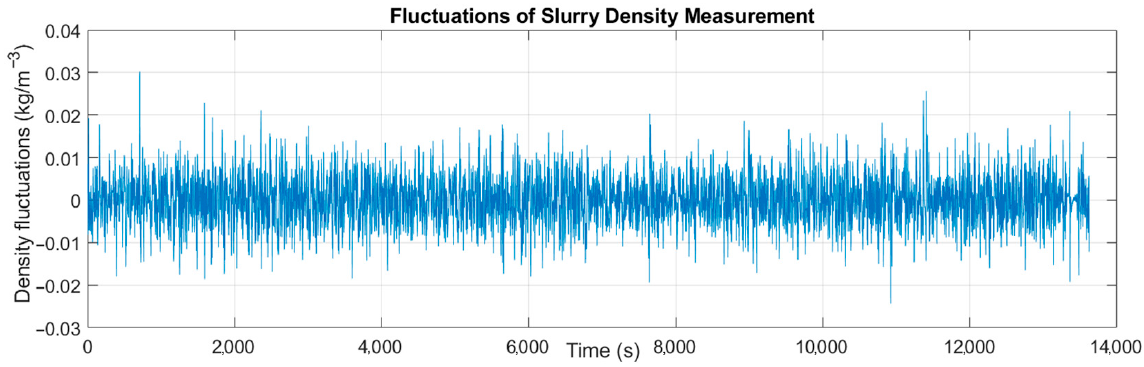
Figure 7. Fluctuations of the slurry density measurement.